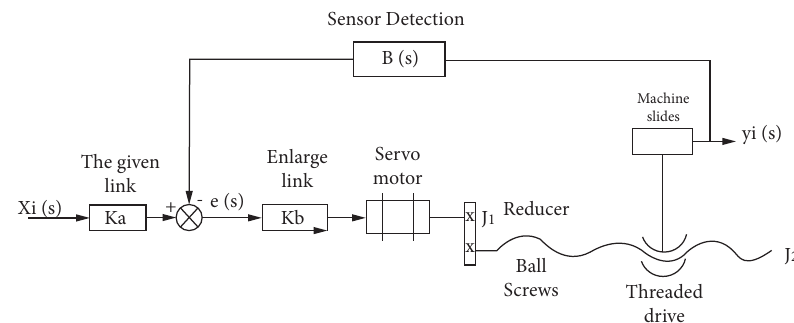
Figure 6: Schematic diagram of the position control system of the machine tool sliding